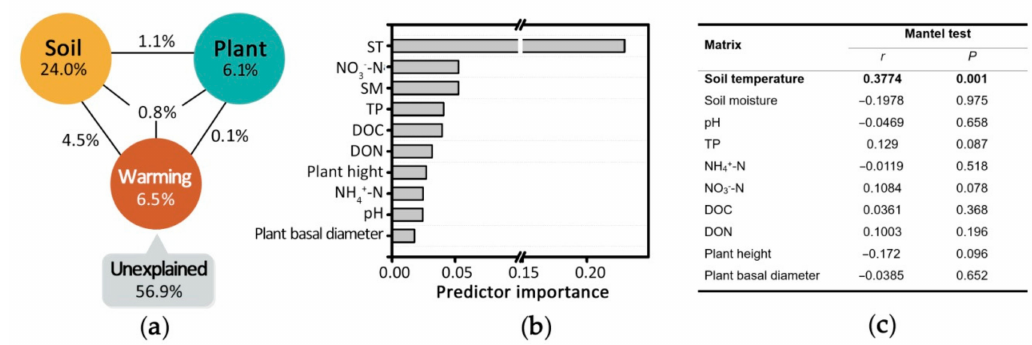
Figure 4. Relationships between environmental factors and samples. ( a ) Variation partitioning analysis (VPA), ( b ) distance-based linear model test, and ( c ) Mantel